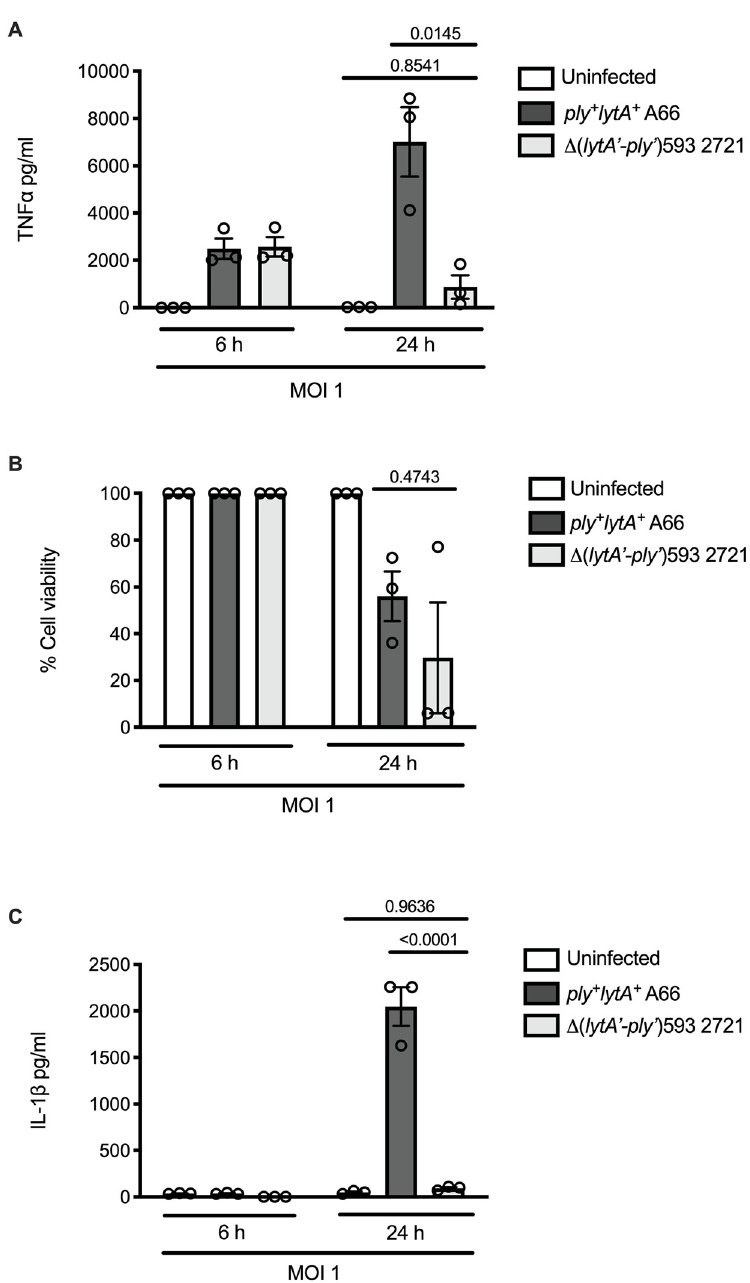
Fig 1. The Δ ( lytA’-ply’ )593 pneumococcal strain 2721 is less inflammatory than the ply + lytA + serotype 3 strain A66 in murine primary BMDMs. Wild type primary BMDMs from C57Bl/6 mice were infected with S . pneumoniae Δ ( lytA’-ply’ )593 strain 2721 or S . pneumoniae ply + lytA + strain A66 at an MOI 1 of for 6 h or 24 h. TNF α production in the supernatant was quantified by ELISA analysis (A). Cell viability was measured by LDH cytotoxicity assay (B). IL-1 β production in the supernatant was quantified by ELISA (C). Data depicted represents the raw values, with the mean and SEM from three independent experiments. Statistical analysis: One-way ANOVA with Tukey’s multiple comparison test. Adjusted P-values